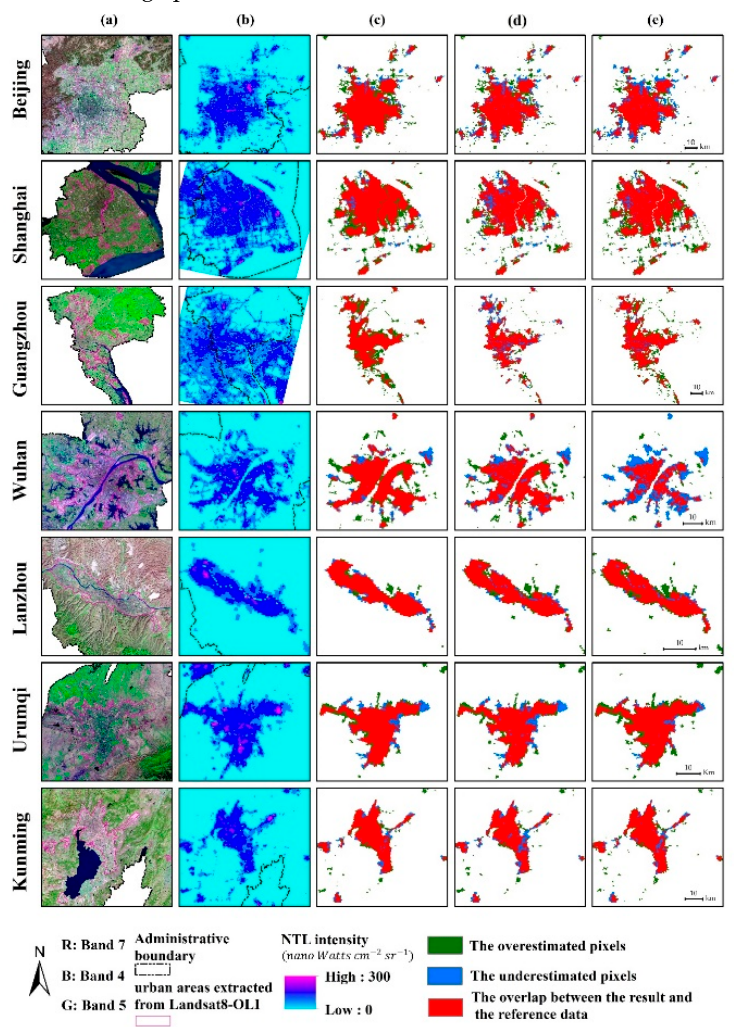
Figure 7. Urban extent extraction results: ( a ) Landsat8 OLI Images of selected cities, ( b ) VIIRS NTL images of selected city, ( c ) the urban extent extracted using our method, ( d ) the urban extent extracted using local optimal threshold (LOT), ( e ) the urban extent extracted using INNL-SVM.